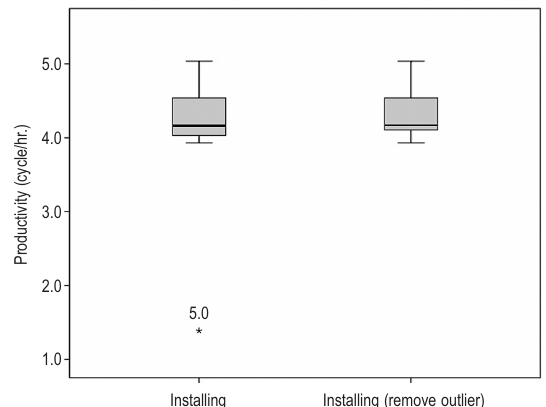
Fig. 5. Boxplot of the measured productivity